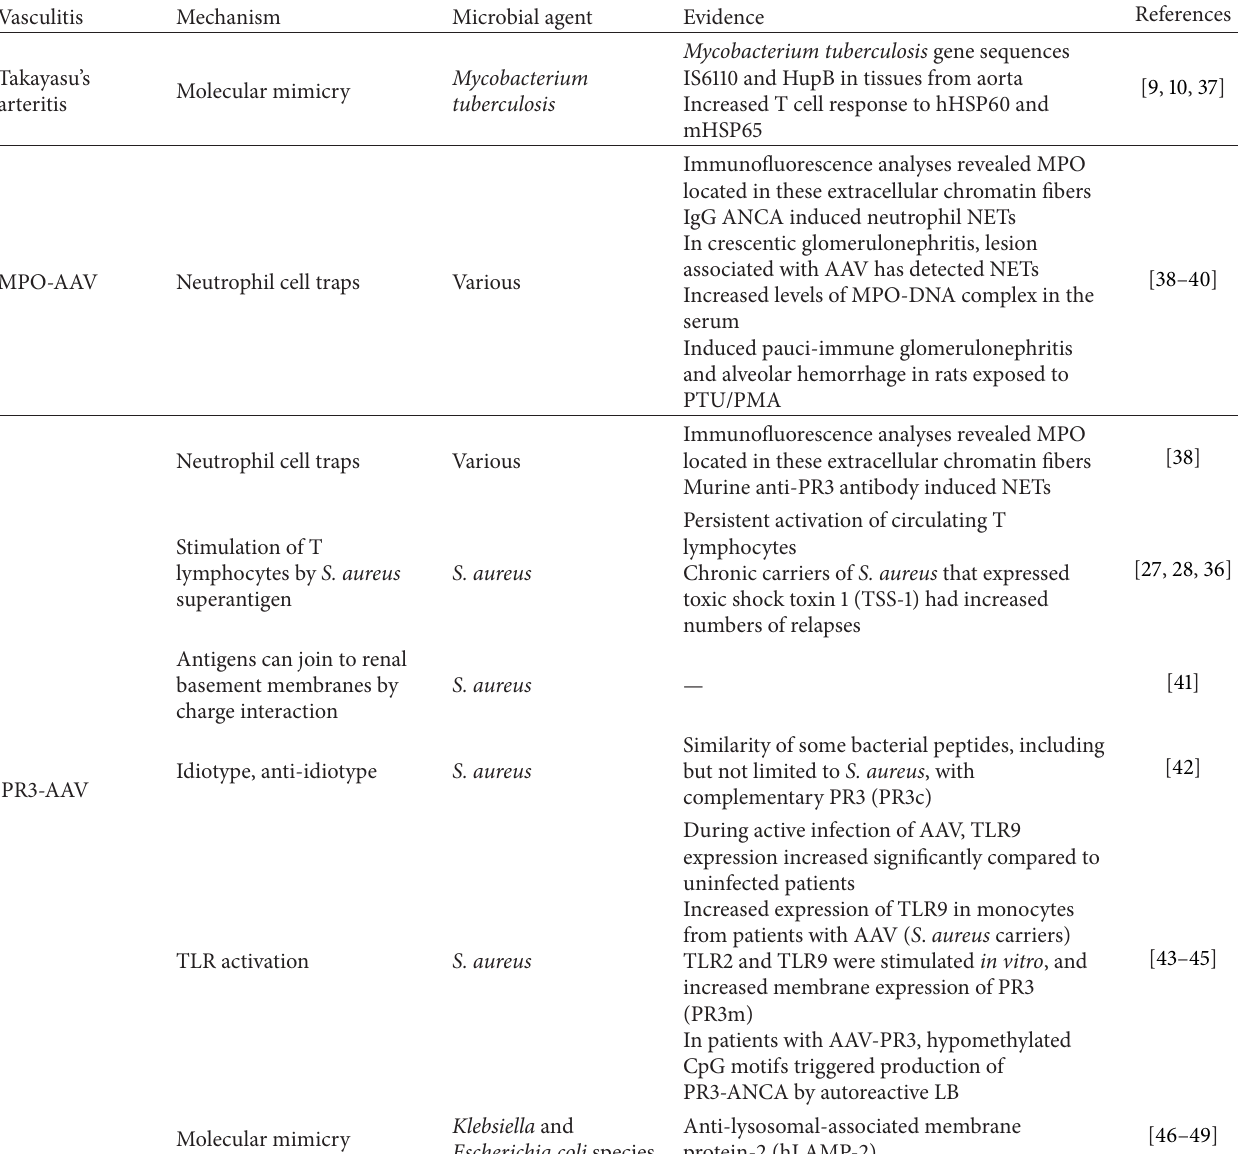
Table 2: Theories regarding the role of infection in the development of primary systemic vasculitis. Toll-like receptor (TLR); 3 proteinase (PR3); myeloperoxidase